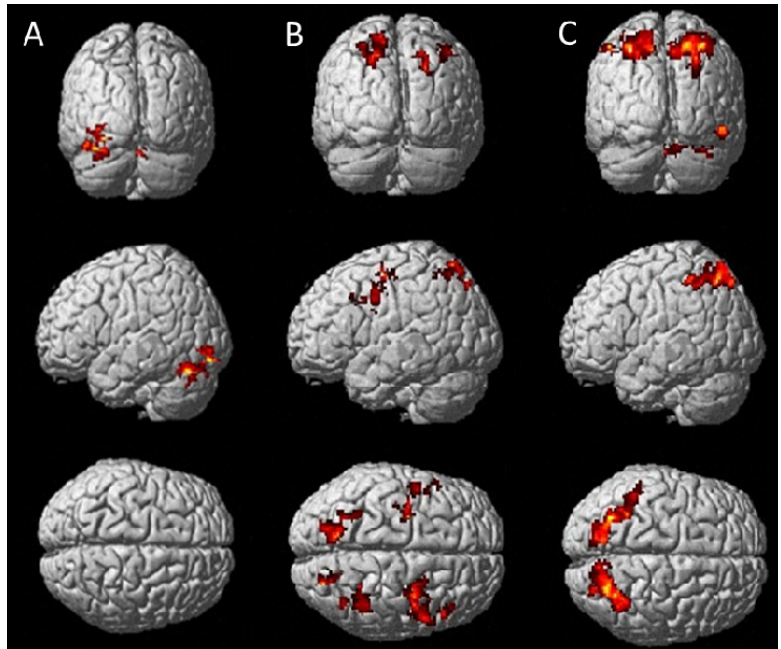
Figure 2. Posterior ( top panel ) and left lateral surface ( middle ) and dorsal ( bottom ) views of brain surfaces showing activation during the RVIP task for Berocca Performance > Placebo ( A ), Berocca Boost > Placebo ( B ) and Berocca Boost > Berocca Performance ( C ).